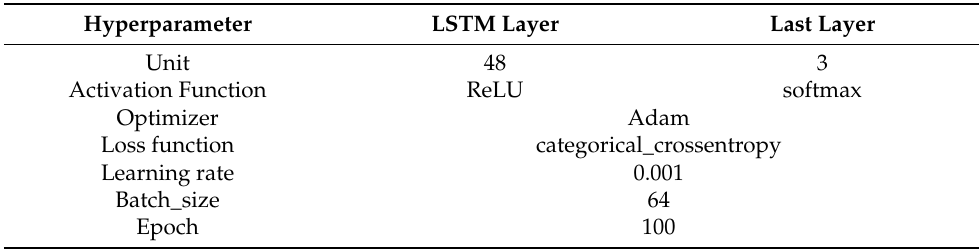
Figure 7. Deep learning model used in the experiment. Table 3. Value of hyperparameters used in the deep learning model.